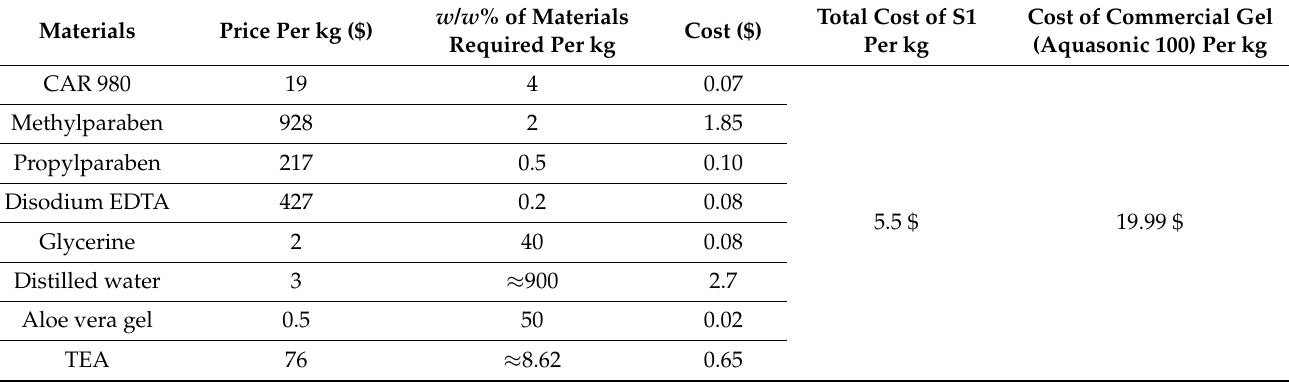
Table 4. Cost analysis of the selected formulation (S1) in comparison with the commercial gel.